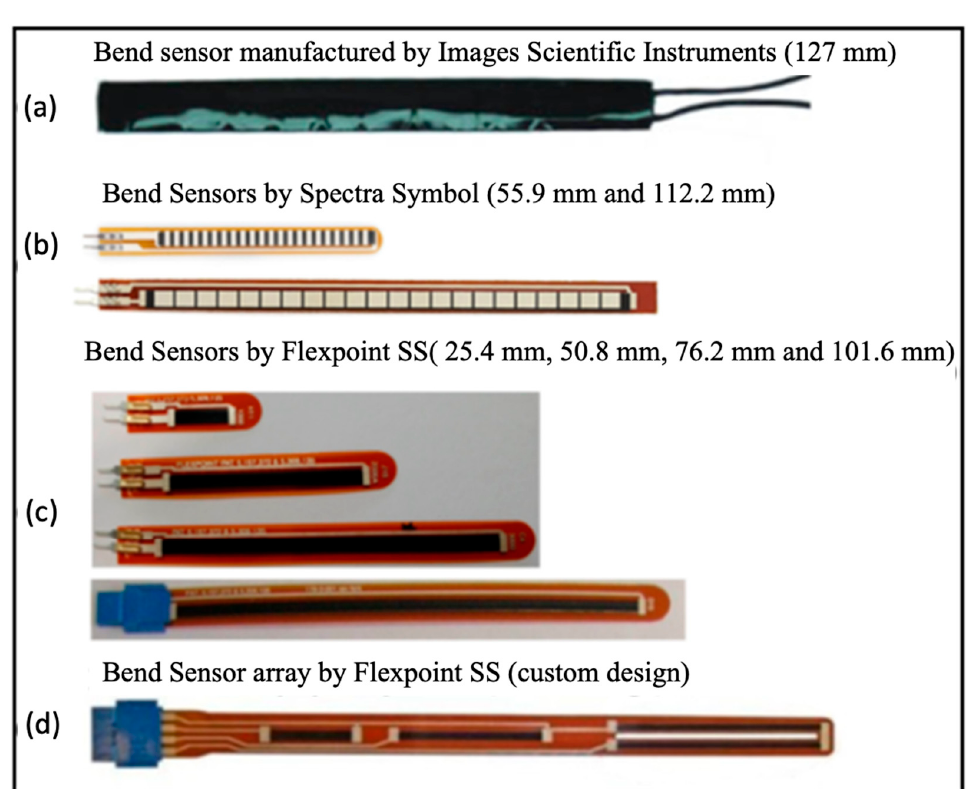
Figure 1. Images of commercial bend sensors ( a ) bi-directional bend sensors manufactured by [5]; ( b ) bend sensors produced by Spectra Symbol [12]; ( c ) bend sensors with different lengths manu- factured by Flexpoint SS [12]; ( d ) custom design, bend sensor array produced by Flexpoint SS [14]. A possible means of improving stability is by the use of a polymer overlay. Borghetti et al. [12] reported that the resistance of polyimide, polyester, and bare bend sensors var- ied by about 2%, 3%, and 30%, respectively, after bending at 90° for 180 s. Therefore, the over-coated sensors with polyester or polyimide are generally more stable than bare bend sensors.